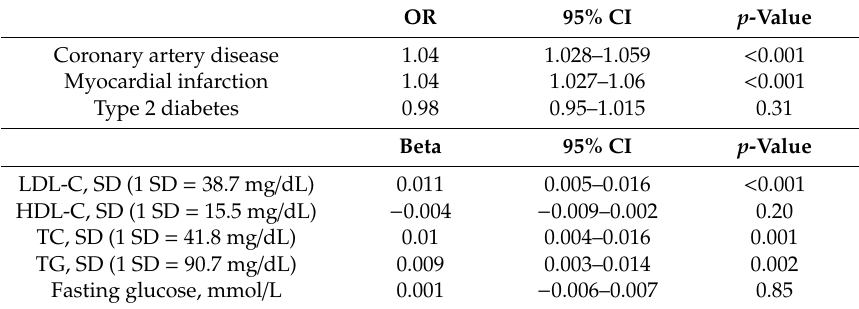
Table 3. MR estimates of causality between vitamin E levels (mg / L) and cardiovascular risk factors, diabetes and coronary artery disease, excluding rs964184 from analysis. OR 95% CI p -Value Coronary artery disease 1.04 1.028–1.059 < 0.001 Myocardial infarction 1.04